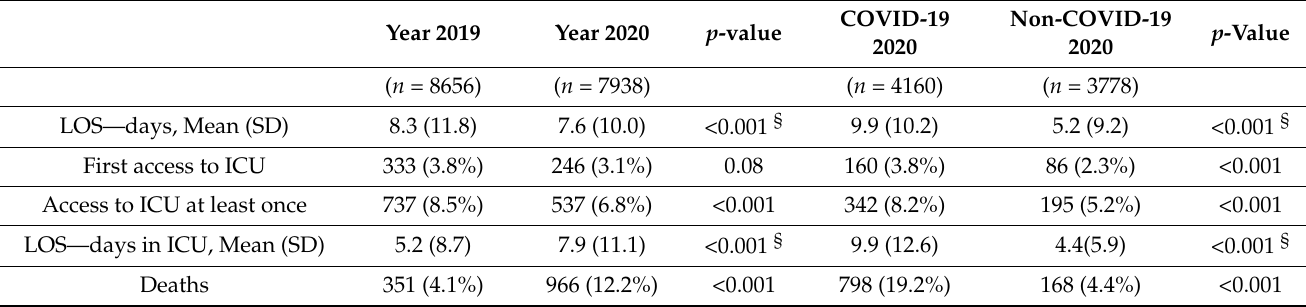
Table 2. Admissions to intensive care unit (ICU), hospital stay and in-hospital